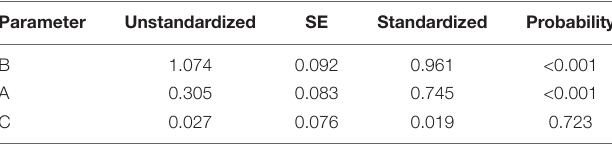
TABLE 5 | SEM structural coefficients: individual level ARRMA